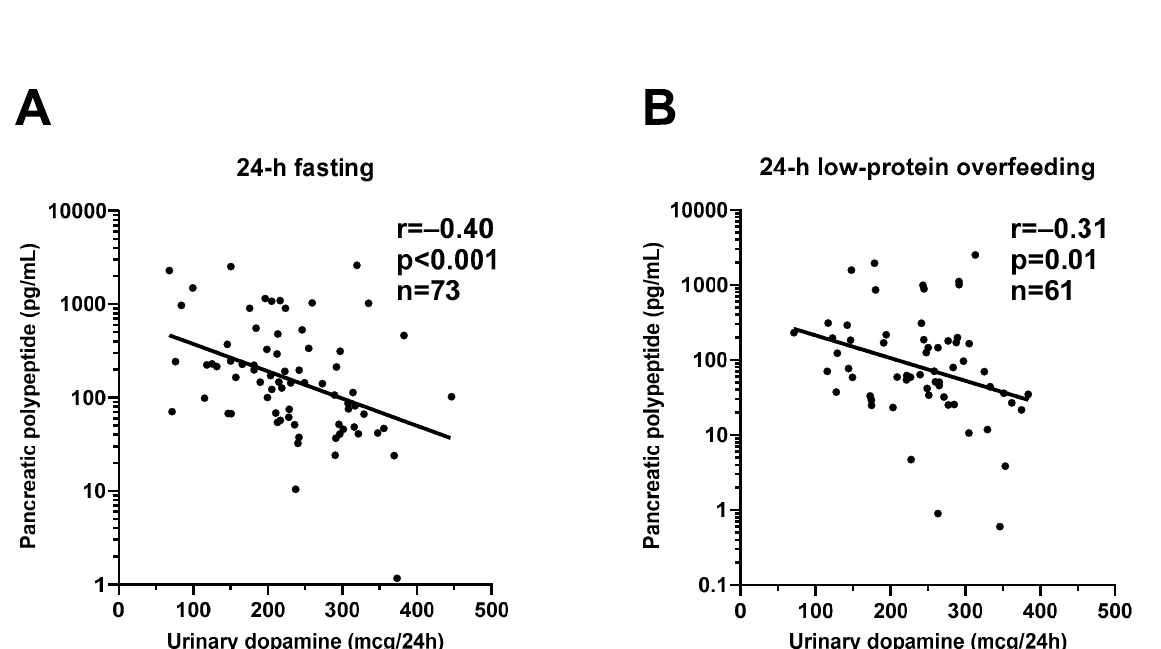
Figure 5. Inverse relationships between urinary dopamine excretion rate and plasma pancreatic polypeptide concentration during 24-h fasting and during 24-h low-protein overfeeding. The graphs show the inverse relationship between 24-h urinary dopamine excretion rate and plasma pancreatic polypeptide concentration after 24-h fasting (Panel ( A )) and after 24-h low-protein overfeeding (Panel ( B )). In each panel, the Pearson’s correlation coefficient (r) is reported along with its significance ( p ). The sample size refers to volunteers who had available measurement for both dopamine and pancreatic polypeptide concentrations.